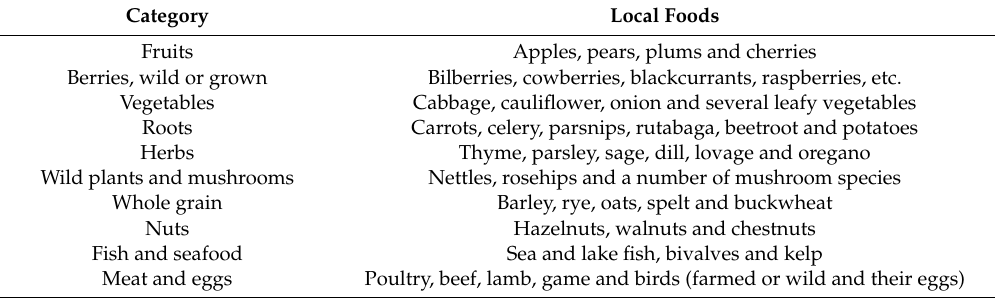
Table 2. Illustration of foods produced or growing in the wild in the Nordic countries. Category Local Foods Fruits Apples, pears, plums and